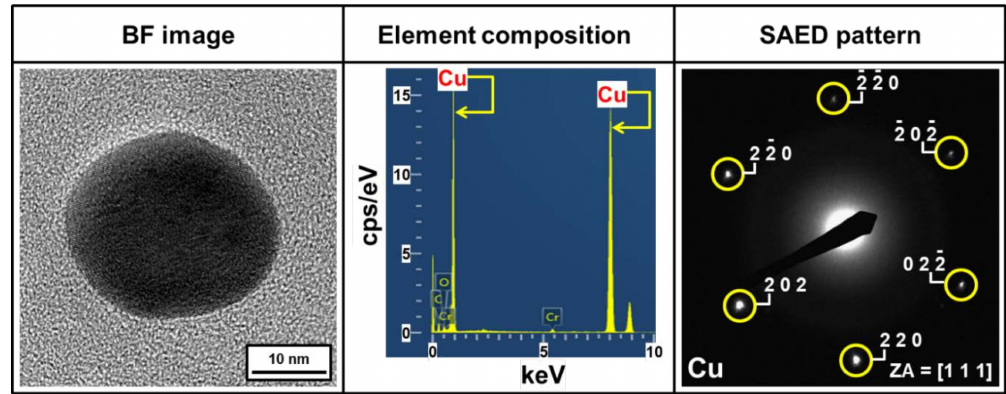
Figure 16. Representative TEM micrograph (Cu precipitates) obtained using the replica method for the base metal region of P21 steel after laser-assisted heat treatment at 1473 K and its corresponding EDS and SADP analysis.